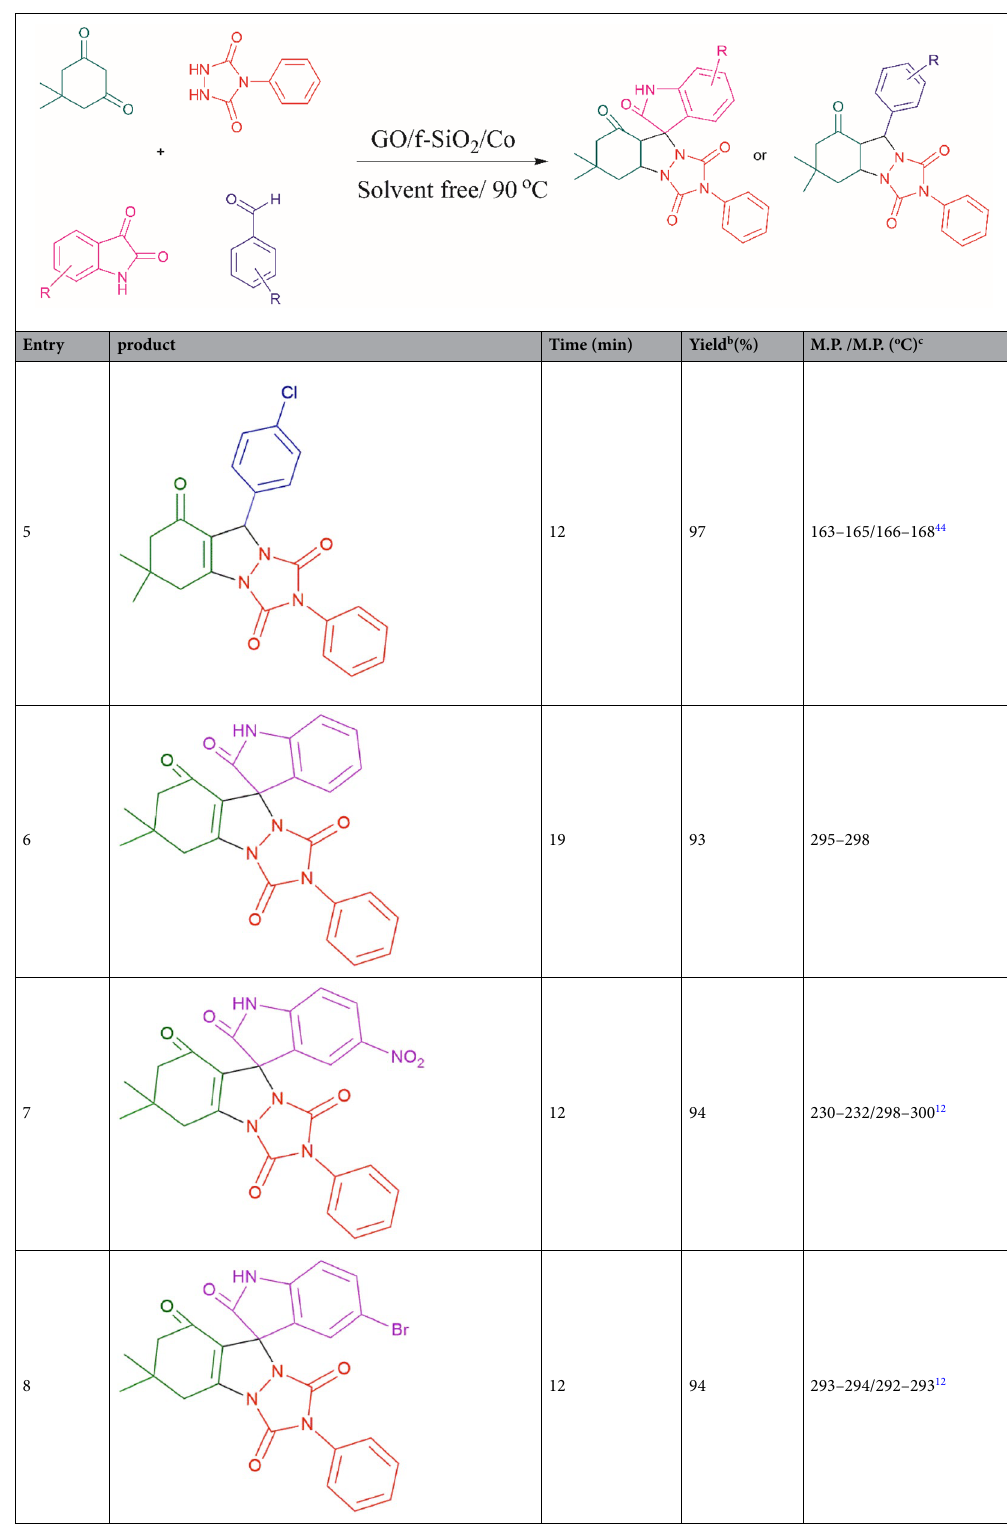
Table 2. synthesis of triazolo[1,2-a]indazole-trione and spiro triazolo[1,2-a]indazole-tetraones a . a